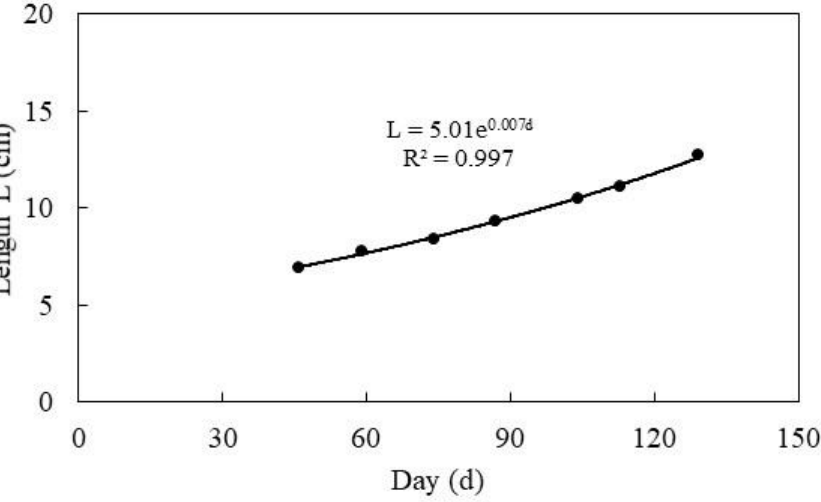
Figure 4. Neopetrosia sp. Exponential regression curve (LM, t 0.006, 5 = 7.9 × 10 − 5 , p = 2.0 × 10 − 7 ) confirming an essentially constant average growth rate of 0.7% d − 1 in terms of specimen length L. Based on data from [37] shown in Table A4.